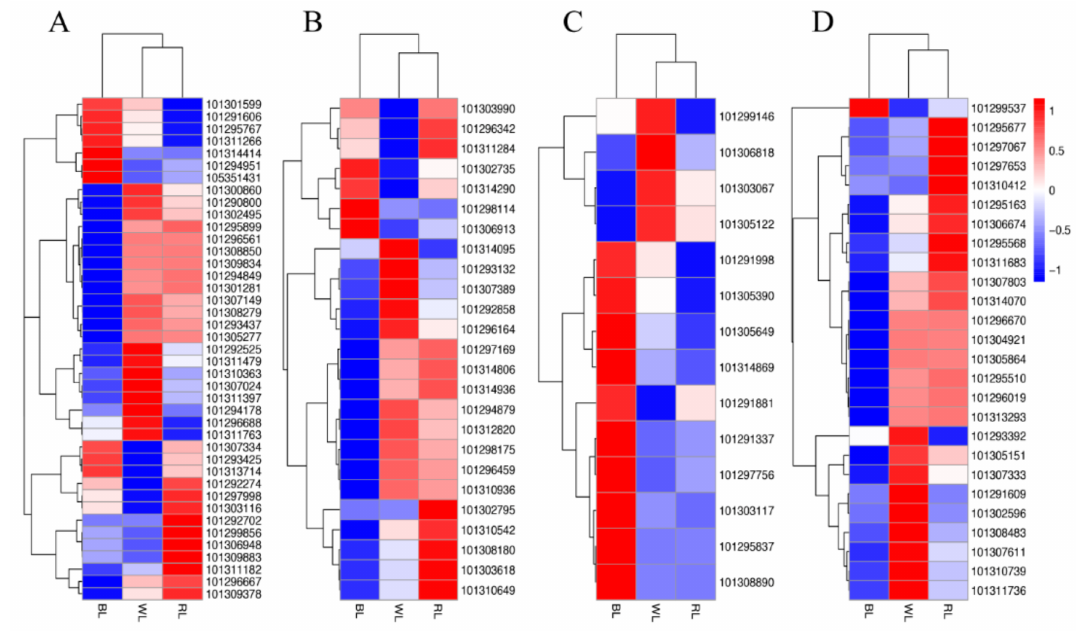
Figure 5. Expression profile clustering of transcription factors related to anthocyanin biosynthesis. ( A ) MYB; ( B ) bHLH, basic helix-loop-helix; ( C ) WD40; and ( D ) WRKY. The color scale at the right represents the re-processed log10 (FPKM+1) using Pheatmap, representing the relative expression level. The expression variance for each gene is indicated by colors ranging from low (blue) to high (red). WL, RL, and BL indicates samples treated by white light, red light, and blue light,